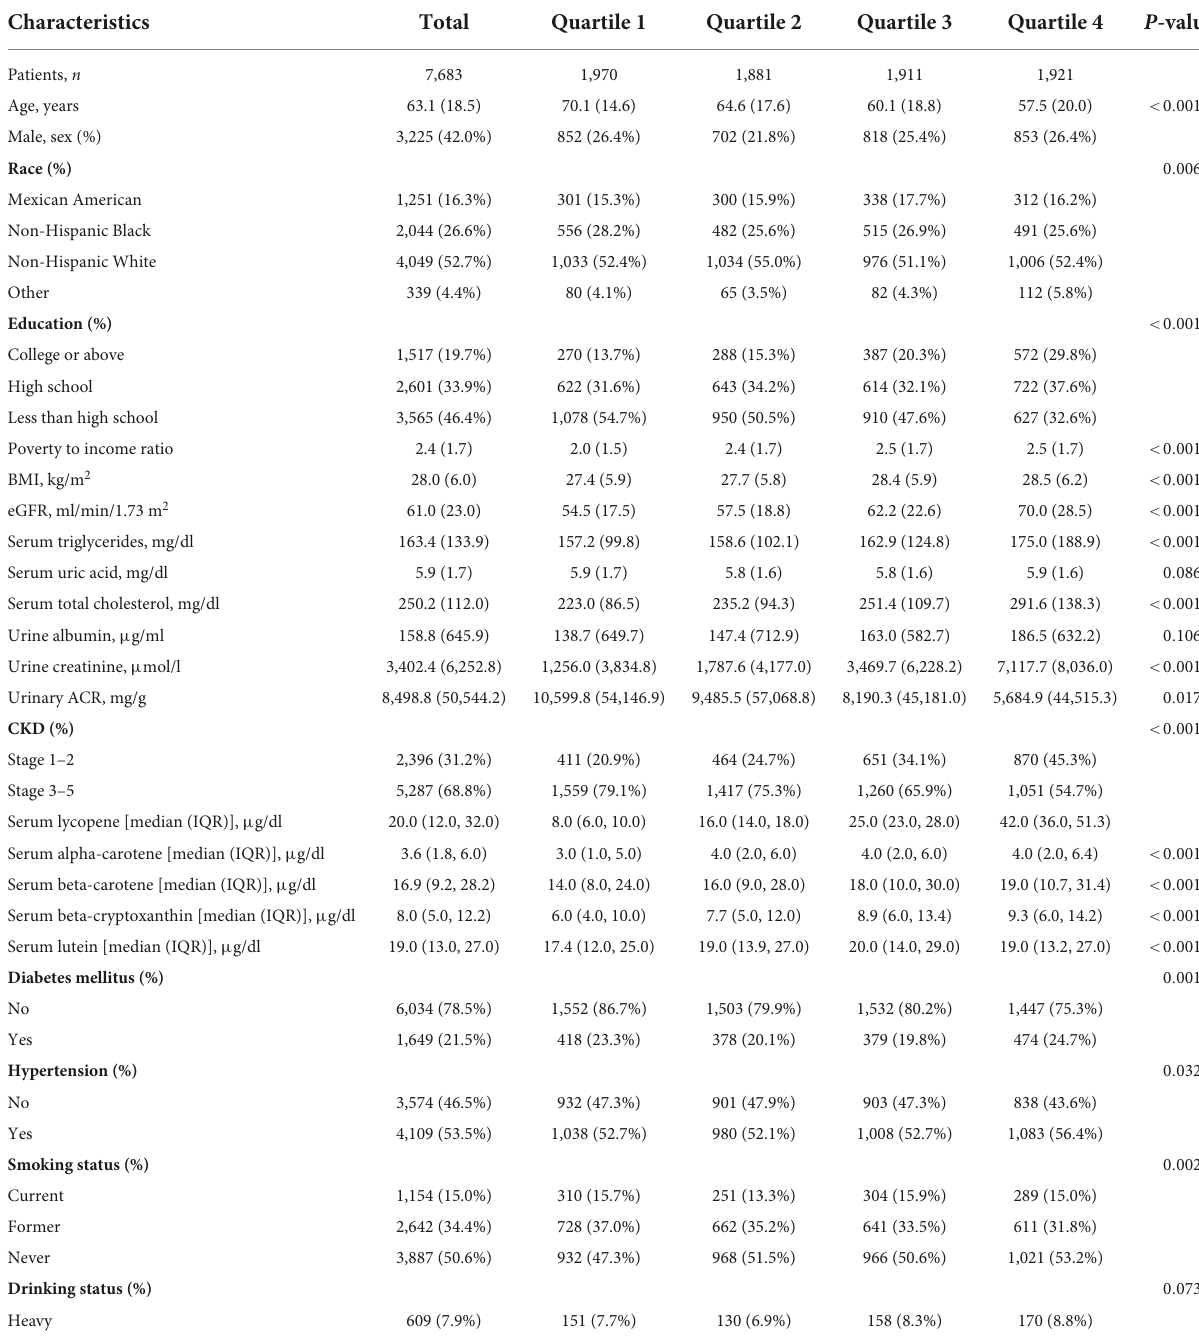
TABLE 1 Baseline characteristics of patients with chronic kidney disease in NHANES III and NHANES